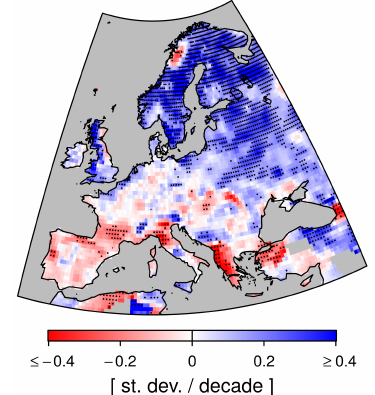
Figure 3. Spatial pattern of SPI-12 trends in December. Colours and symbols are equivalent to Fig.